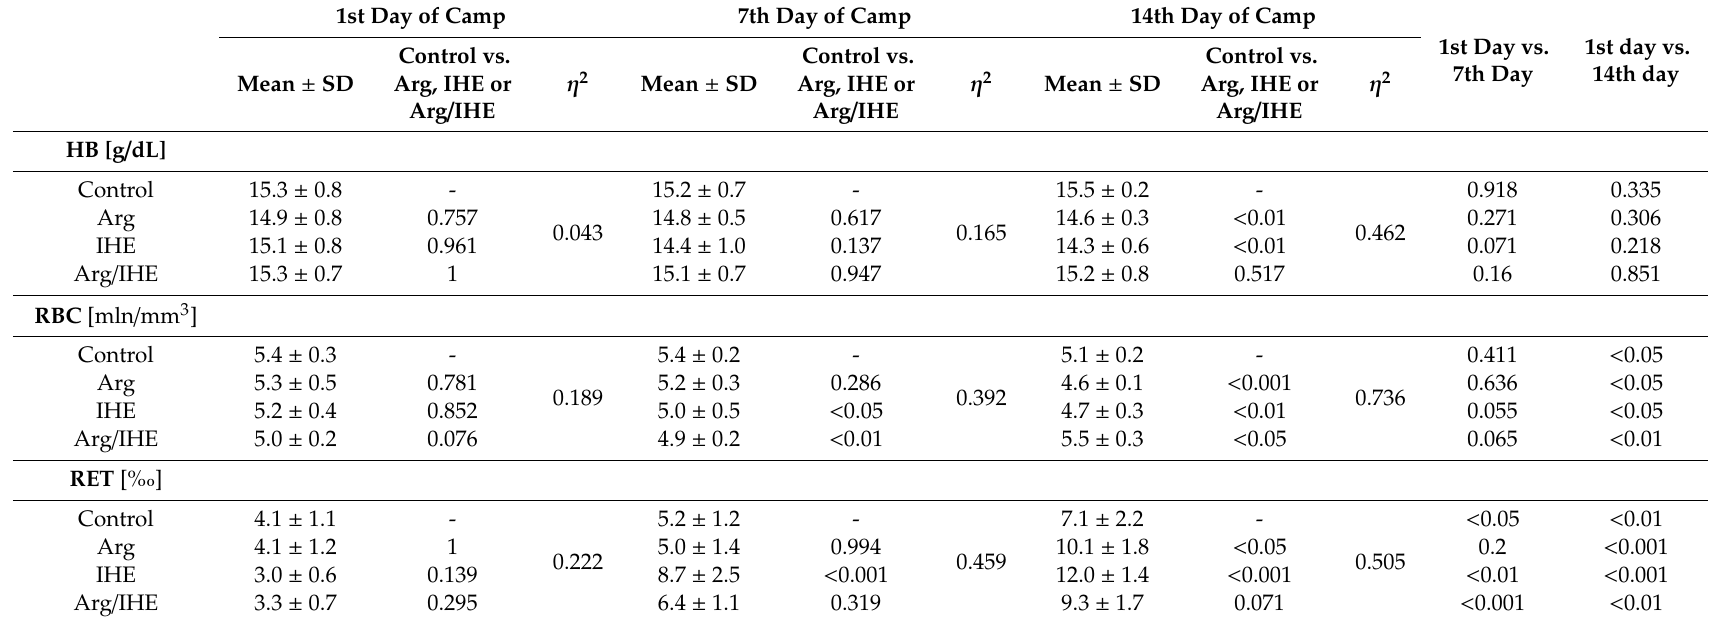
Table 5. Haematological markers and immune cells